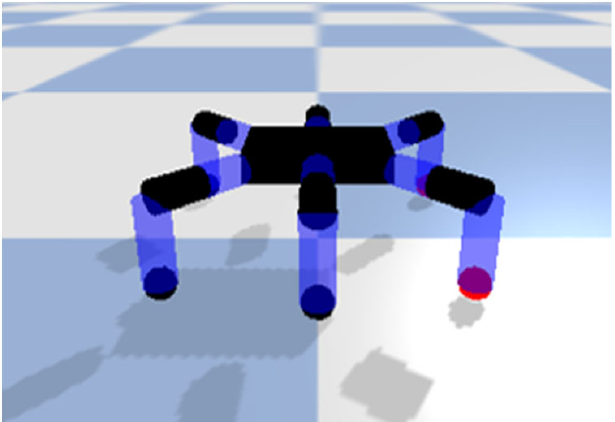
Figure 1. Simulated prototype of the hexapod robot.